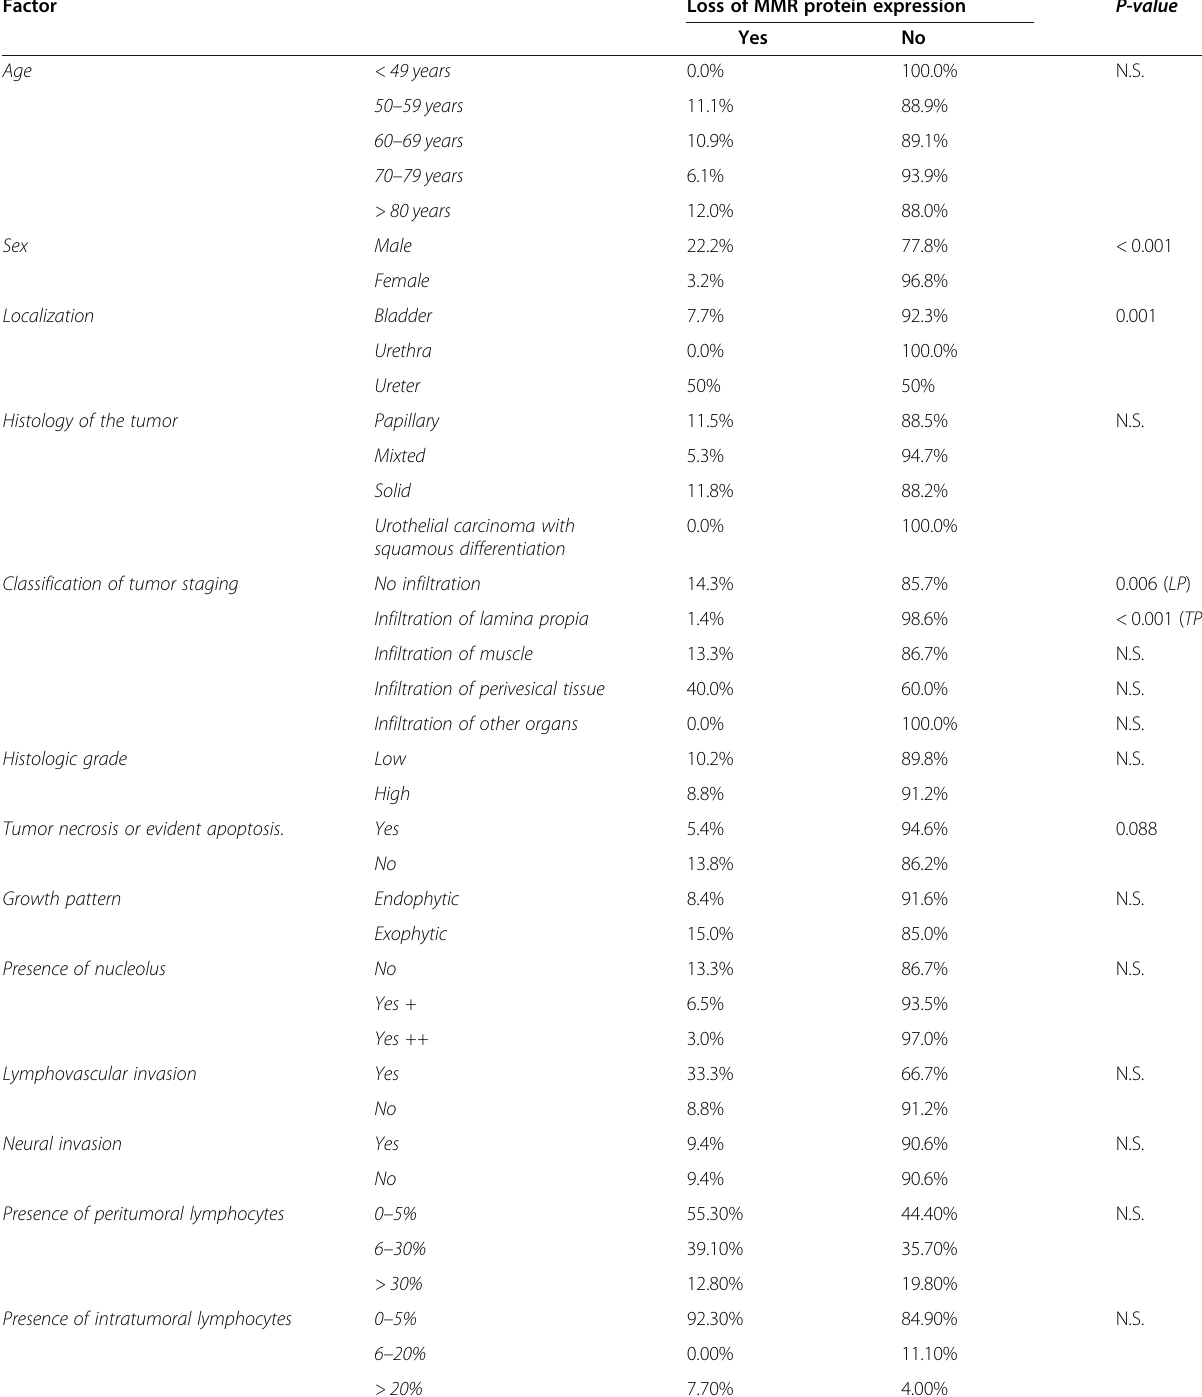
Table 4 Correlation between the presence or absence of loss of MMR protein expression with parameters of influence in the different tumors